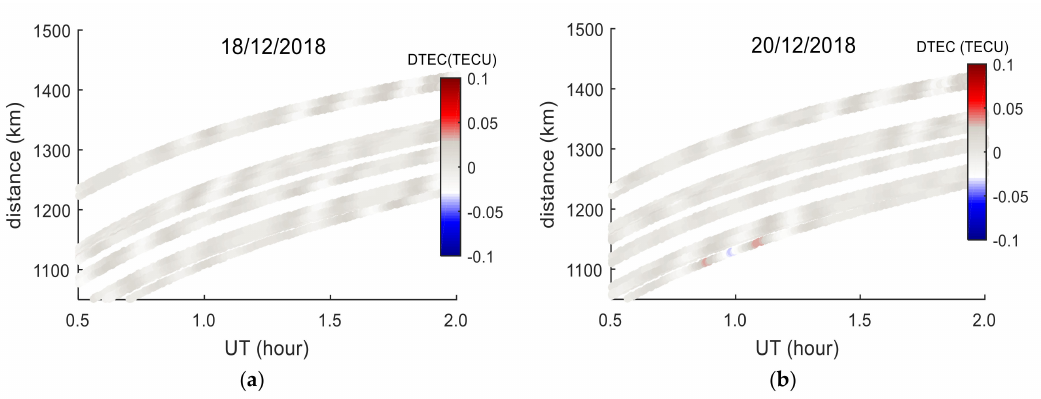
Figure 14. TEC disturbance distance-time graphs estimated by 20 GPS stations and PRN05 satellites on 18th and 20th.